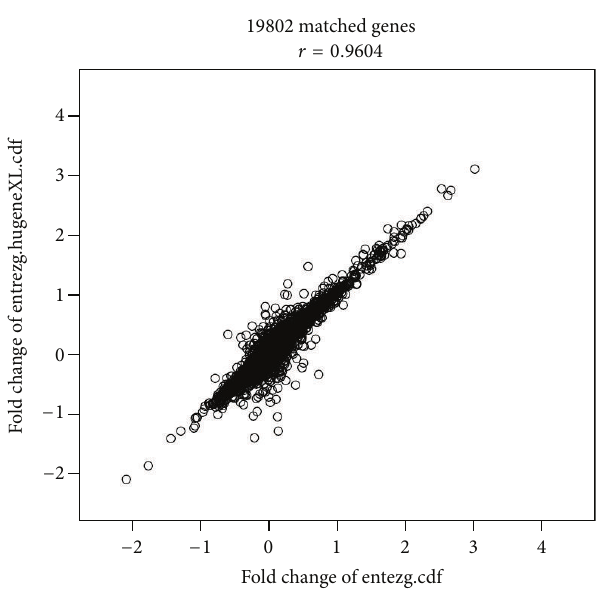
Figure 4: The fold change comparison of smoking-induced gene expression changes for a total of 19,802 matched genes between two different